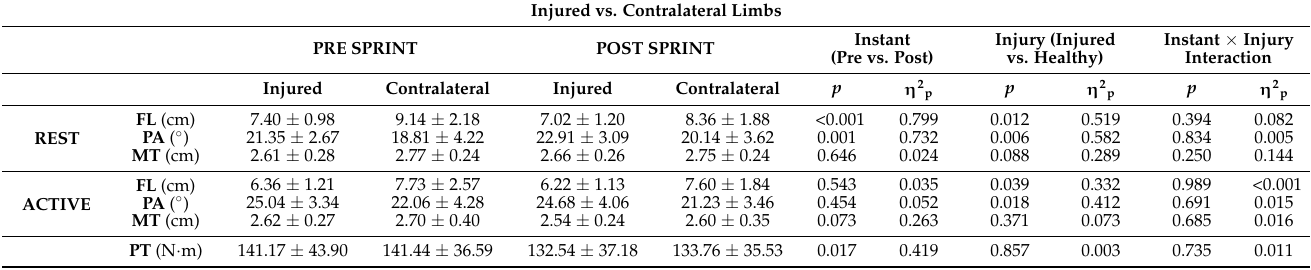
Table 2. Acute effects of a sprint protocol on BFlh injured vs. contralateral limbs on: fascicle length (FL), pennation angle (PA), muscle thickness (MT) and peak torque (PT) before and after sprint task. Data are presented as mean ± standard